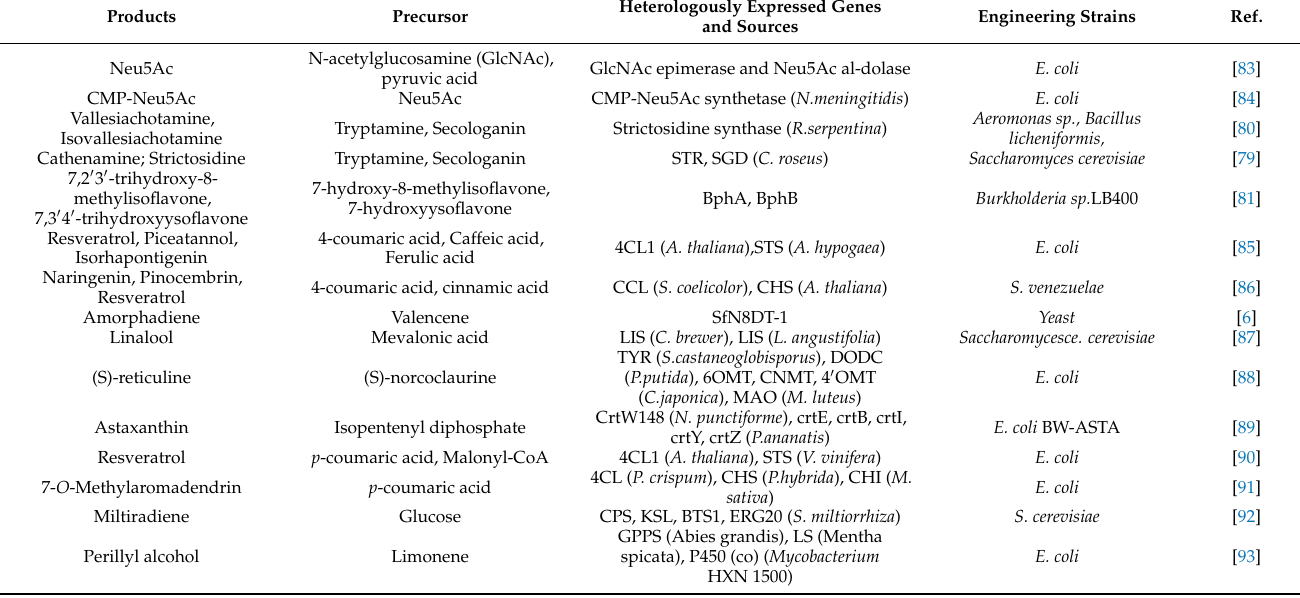
Table 2. Products precursor heterologously expressed genes and sources engineering